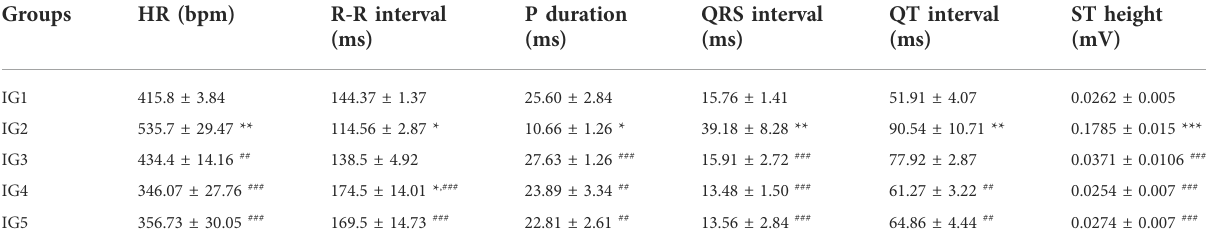
TABLE 1 Electrocardiographic fi ndings of experimental groups depicting the effect of ISO and GC pretreatment. Results are expressed as mean ± SD for groups of three observations, Statistically signi fi cant at *** p < 0.001, ** p < 0.01, * p < 0.05 as compared to IG1 and ### p < 0.001, ## p < 0.01, # p < 0.05 when compared to IG2 as calculated by one-way ANOVA followed by Dunnet ’ s multiple comparison tests. Groups